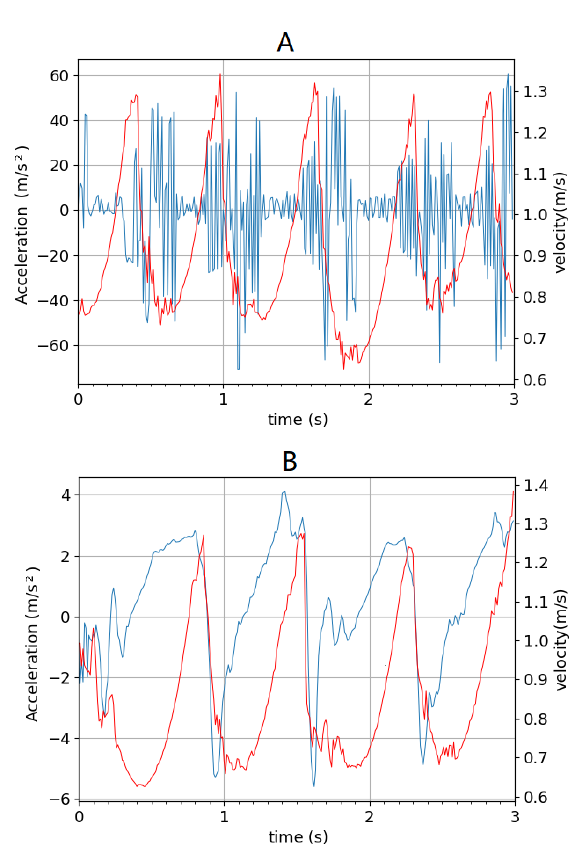
Figure 5. ( A ) Before and ( B ) after filtering. The blue line indicates the acceleration; the red line indicates the velocity.